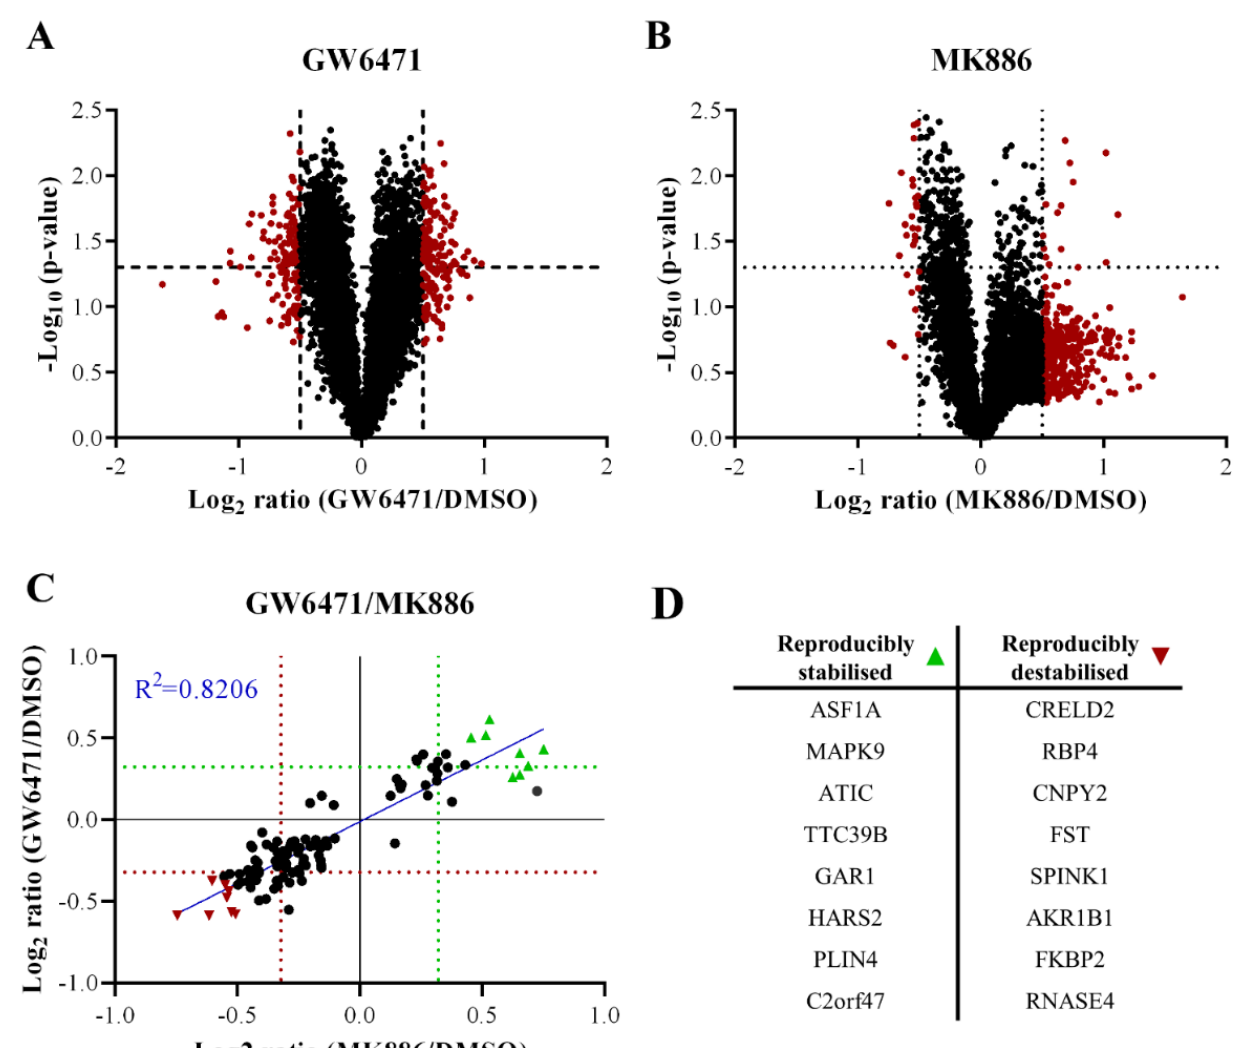
Figure 4. PISA analysis of donor 1 PHH spheroids treated with 50 µ M GW6471, 100 µ M MK886 or 0.1% ( v / v ) DMSO for 2 h. In all panels, the dotted lines indicate a threshold of 0.4 change in protein amount ratio or a p-value threshold of 0.05. ( A ) Volcano plot showing the fold change in soluble amount after thermal treatment (Log 2 ratio) and statistical significance expressed as − Log 10 ( p -value) of GW6471 and DMSO-treated spheroids. ( B ) Volcano plot showing the fold change in soluble amount after thermal treatment ( − Log 2 ratio) and statistical significance expressed as − Log 10 ( p -value) of MK886 and DMSO-treated spheroids versus DMSO. ( C ) Correlation between similarly altered proteins in GW6471 and MK886 treatments. The proteins significantly increased in soluble amounts in both GW6471 and MK886 treatments as shown in green triangles, while proteins labelled with red triangles are significantly and commonly decreased in soluble amounts. ( D ) Summary table of the significantly and commonly altered proteins labelled in panel